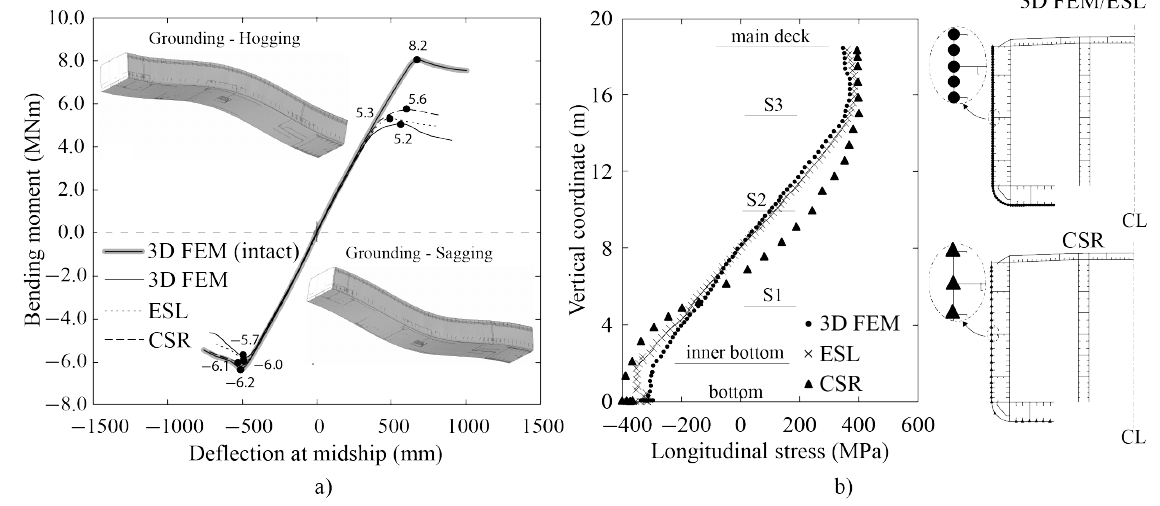
Figure 13. Response of ship grounding under vertical bending moment. ( a ) Bending moment– deflection curves. The maximum bending moments are used in calculating the histogram of moment reduction ratio. ( b ) Longitudinal stress distribution to vertical coordinate at the midship under hogging condition.